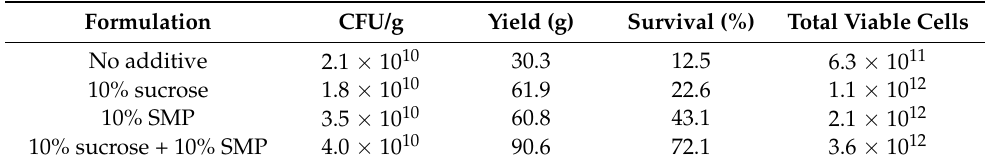
Figure 1. Freeze-dried M. pulcherrima formulations stored at 4 °C are stable over several years. ( A ) Freeze-dried cells, formulated with a combination of 10% skim milk powder (SMP) and 10% sucrose, were stored at 4 °C ( ⚫ ) or 22 °C ( ⚫ ). Cell viability was determined by suspending cells in water, diluting, and plating on PDA. Colonies were counted after two days of incubation at 22 °C. ( B ) Freeze-dried cells were produced in 2016 and 2017 (formulated with 10% SMP and 10% sucrose) and stored at 4 °C. The CFU/g was determined directly after freeze-drying (fd) and in February 2020 (02/20). The difference in the initial CFU counts after freeze-drying were due to production differences. Numbers are represented in a logarithmic scale. Each sample was plated four times and the averages and standard errors are shown. Letters indicate statistical significance determined by one-way ANOVA with Tukey’s multiple comparisons test and Benjamini–Hochberg correction ( p < 0.05). Table 1. Yield and survival of different, commercially produced M. pulcherrima dry formulations during the freeze-drying procedure from single fermenter rounds. For all formulations, 320 g of yeast suspension were mixed with the different formulating compounds.